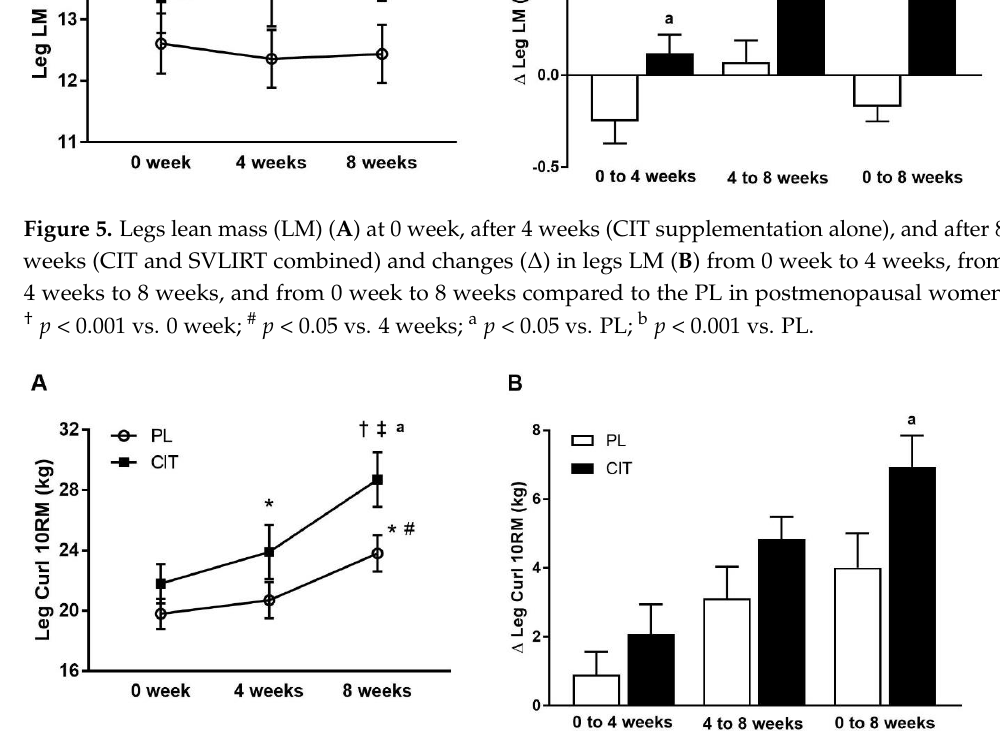
Figure 6. Leg curl 10-repetition maximum (10RM) ( A ) at 0 week, after 4 weeks (CIT supplementation alone), and after 8 weeks (CIT and SVLIRT combined) and changes (Δ) in leg curl 10RM ( B ) from 0 week to 4 weeks, from 4 weeks to 8 weeks, and from 0 week to 8 weeks compared to the PL in postmenopausal women. * p < 0.05 vs. 0 week; † p < 0.001 vs. 0 week; # p < 0.05 vs. 4 weeks; ‡ p < 0.001 vs. 4 weeks; a p < 0.05 vs. PL. LM (r = 0.436, p < 0.05, Figure 7A) and total percent fat (r = -0.528, p < 0.01, Figure 7B).